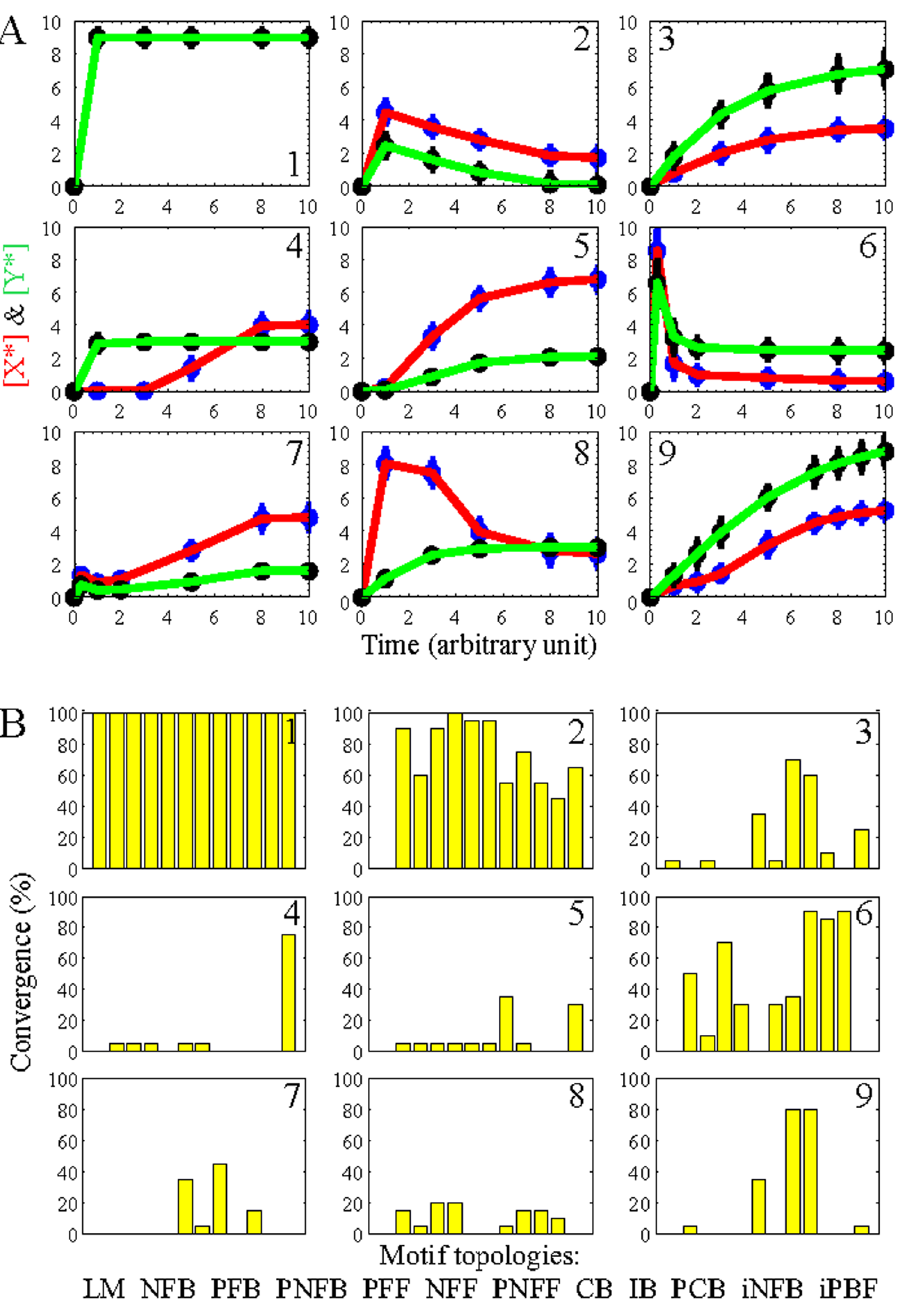
Figure 3. Motif tunability to transient output objectives. A: Predefined time-courses and B: convergence percentage of network motifs to transient output objectives for: 1) fast; 2) slowly decaying; 3) asymptotic; 4) rapid and delayed; 5) sigmoidal; 6) pulse; 7) biphasic; 8) rapid increasing- slow decaying and asymptotic; and 9) multi-static responses. Given the 12 motif topologies, 9 time-course objectives, and 20 attempts to identify the model parameter, PSO was implemented 2,160